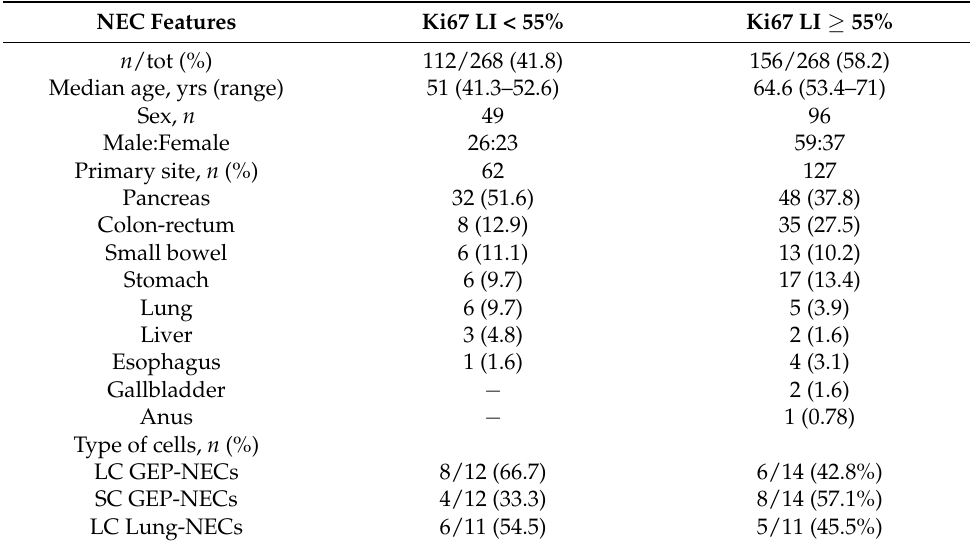
Table 2. Demographic and pathological features of patients with neuroendocrine carcinoma (NEC) and low Ki67 labeling index (LI) vs. high Ki67